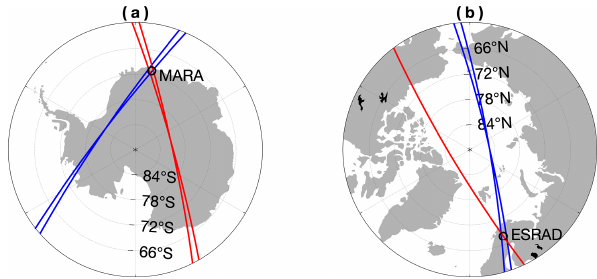
Figure 1. Maps showing the locations of the MARA (a) and ES- RAD (b) radars and typical Aeolus measurement tracks for orbits passing within 100km of the respective radar. Red are ascending tracks, blue descending. At MARA four tracks per week and at ES- RAD three per week pass close to the